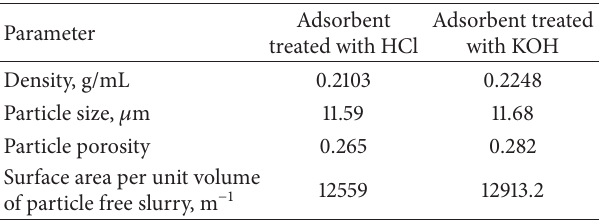
Table 1: The characterisation of the adsorbent treated with HCl and